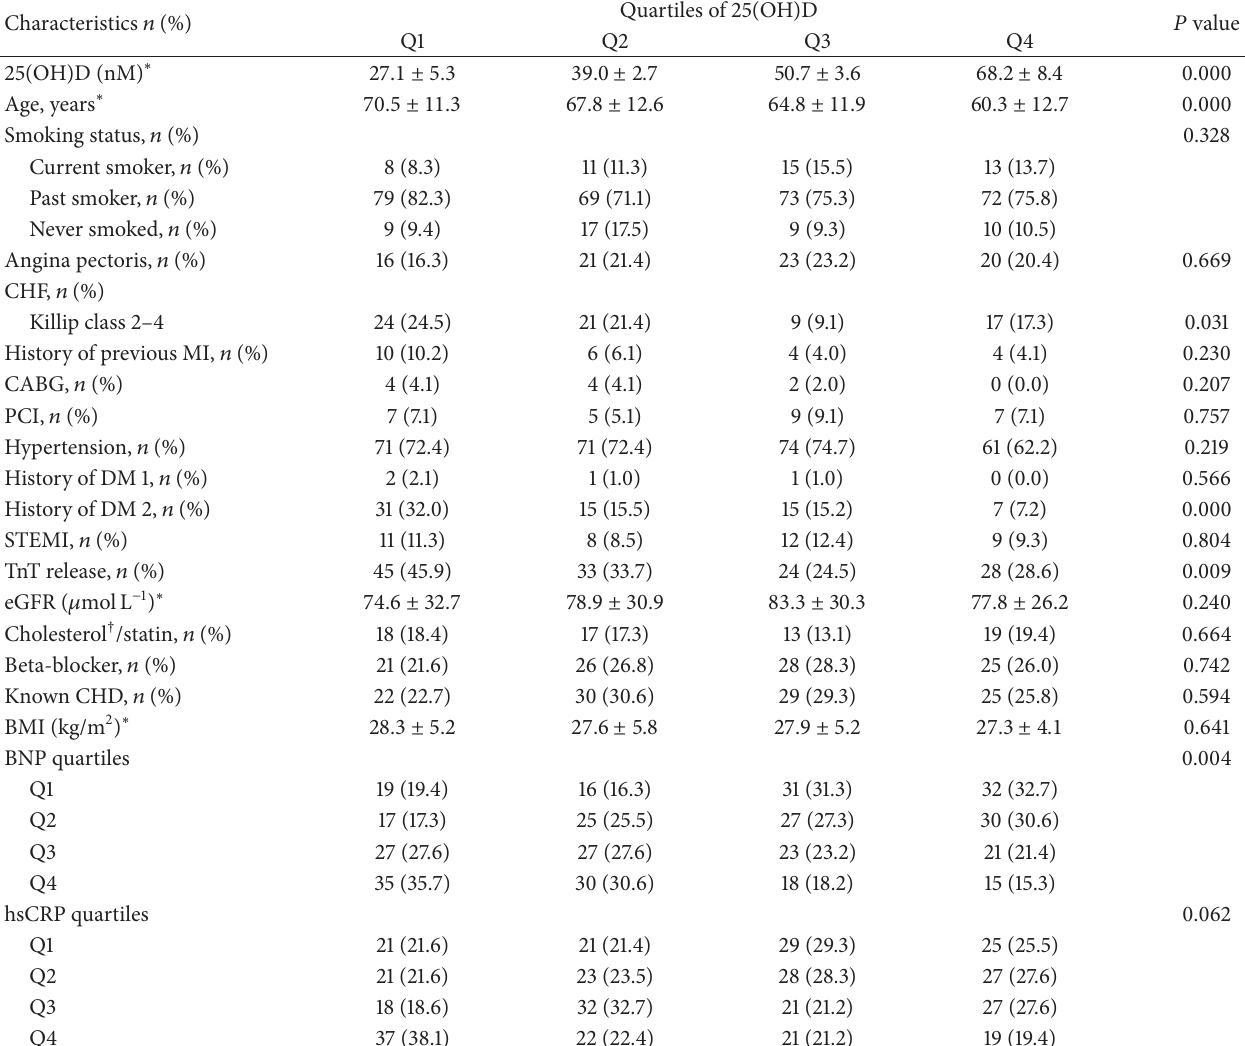
Table 1: Baseline characteristics of female patients arranged according to quartiles of